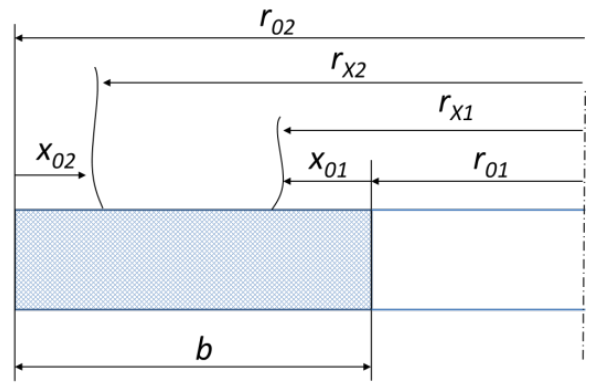
Figure 15: The model of the ring gasket as a porous structure